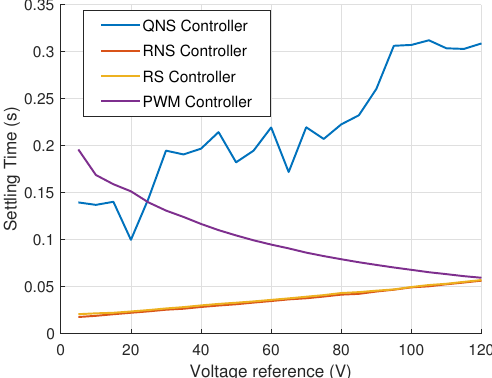
Figure 7. Settling time variation in the range of operation.